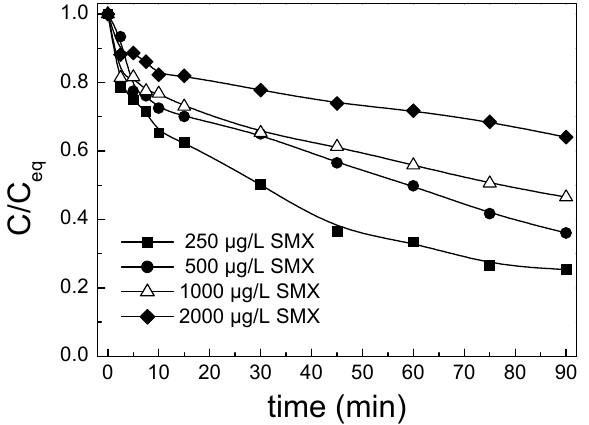
Figure 11. E ff ect of initial SMX concentration on its degradation with 200 mg / L biochar and 1000 mg / L SPS in UPW and inherent Figure 11. Effect of initial SMX concentration on its degradation with 200 mg/L biochar and 1000 mg/L SPS in UPW and inherent pH.